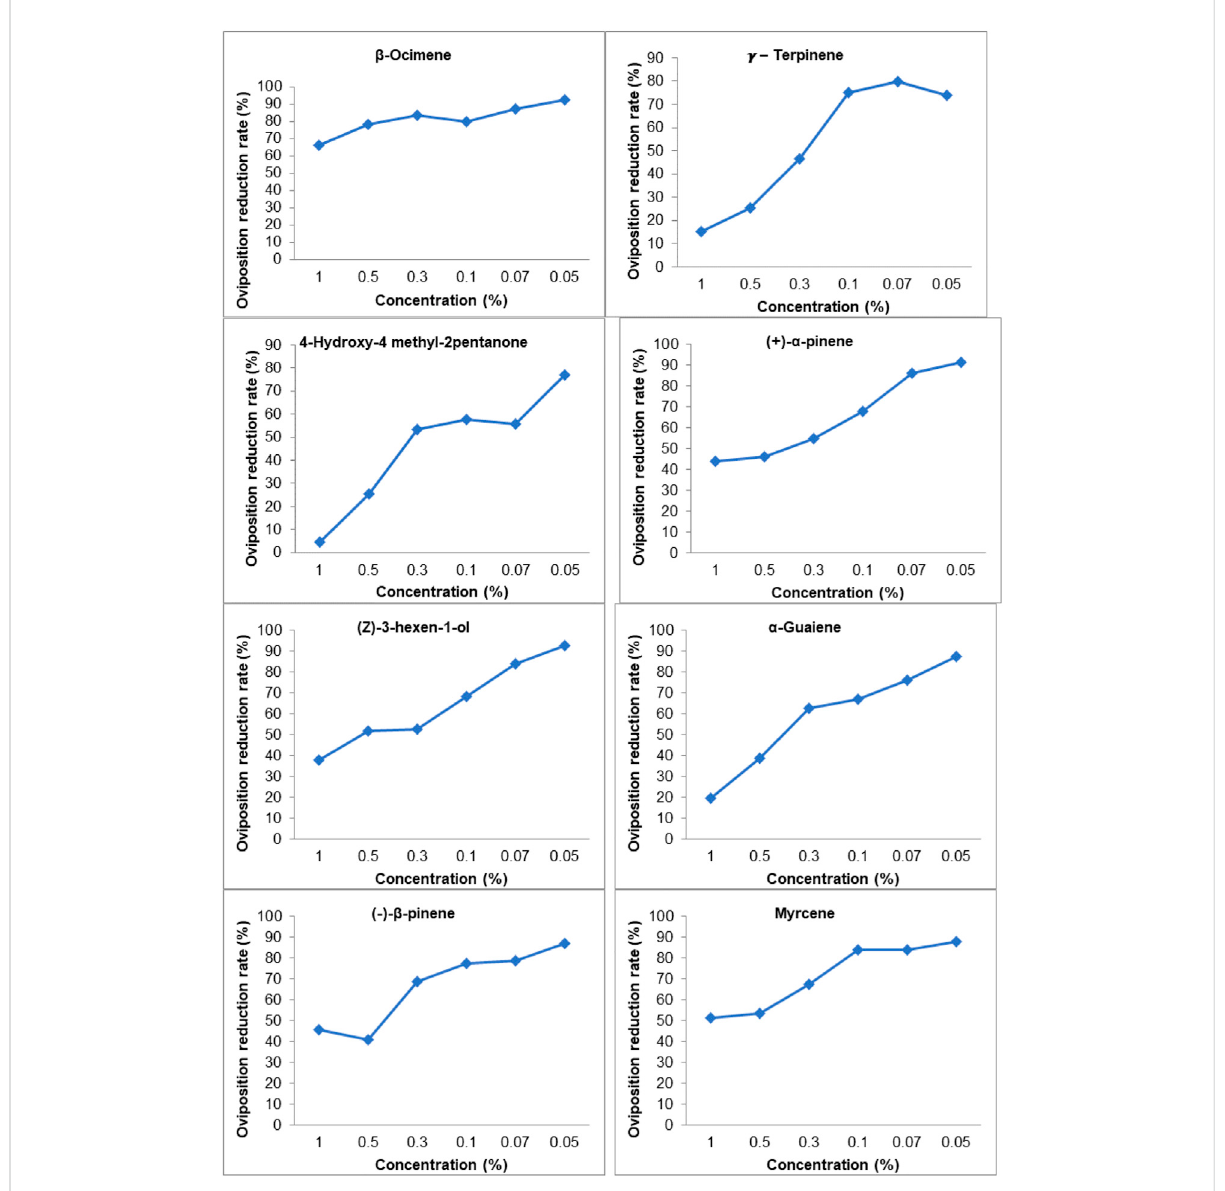
FIGURE 7 Oviposition reduction rate of B. tabaci due to VOC treated cotton leaves, Oviposition reduction rate (%) = [(number eggs on control plant- number eggs on the treated plant)/Number of eggs on control plant] X 100; Values are mean of fi ve